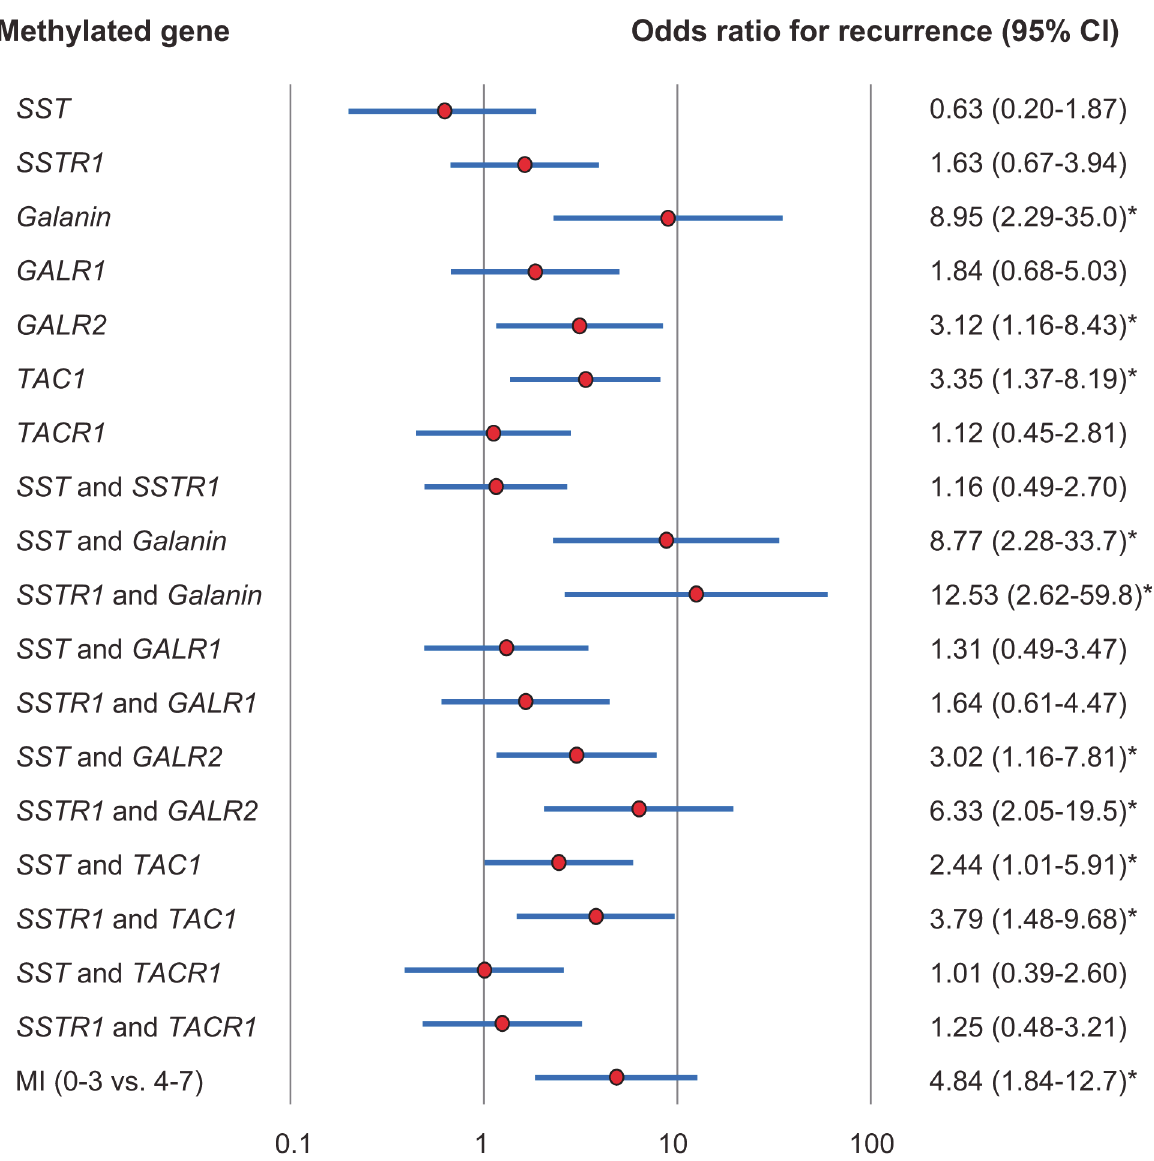
Fig 5. Odds ratios for recurrence based on multivariate logistic-regression adjusted for stage (I, II, III vs. IV), age (65 and older vs. < 65), sex, alcohol exposure, and smoking status. Methylation of SSTR1 and galanin in the primary tumor was associated with the most significant odds ratios of